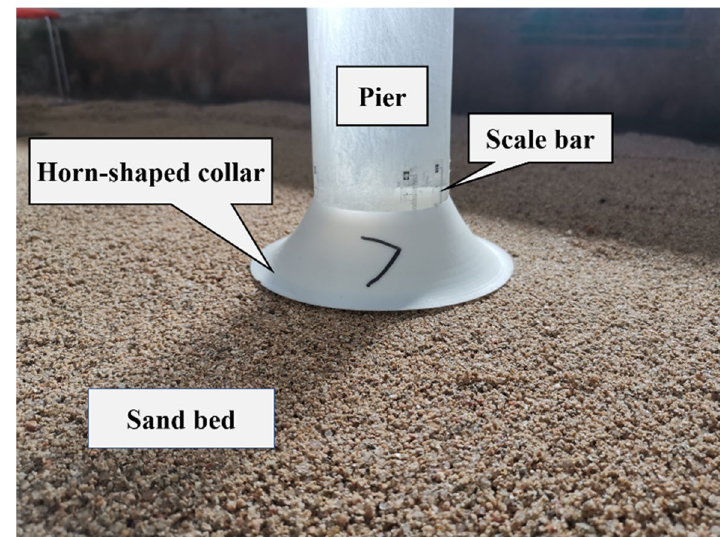
Fig. 4 Configuration of the experimental area before